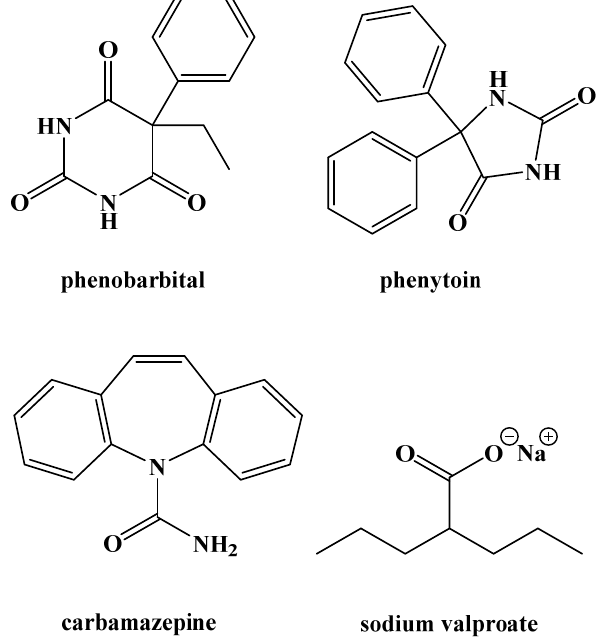
Figure 2. Common Anticonvulsant Medications.